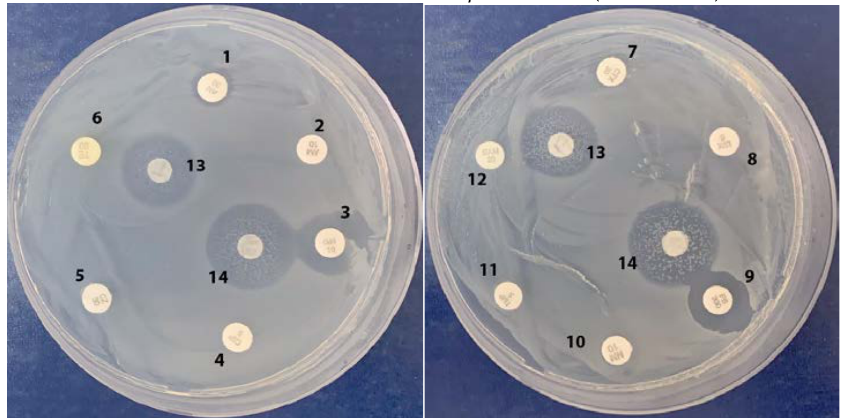
Figure 5. Inhibition of the growth of clinical isolates of MDR K. pneumoniae with antibiotics and peptide derivatives of phosphinothricin. ( 1 ) Amikacin, 30 µg/disk; ( 2 ) Ampicillin, 10 µg/disk; ( 3 ) Gentamicin, 10 µg/disk; ( 4 ) Ciprofloxacin, 5 µg/disk; ( 5 ) Cefazolin, 30 µg/disk; ( 6 ) Tetracycline, 30 µg/disk; ( 7 ) Cefotaxime, 30 µg/disk; ( 8 ) Levofloxacin, 5 µg/disk; ( 9 ) Polymyxin B, 300 IU/disk; ( 10 ) Tobramycin, 10 µg/disk; ( 11 ) Trimethoprim, 5 µg/disk; ( 12 ) Ampicillin/Sulbactam, 10/10 µg/disk; ( 13 ) Bialaphos, 5 µg/disk; ( 14 ) L-Leu-L-PT, 5 µg/disk.